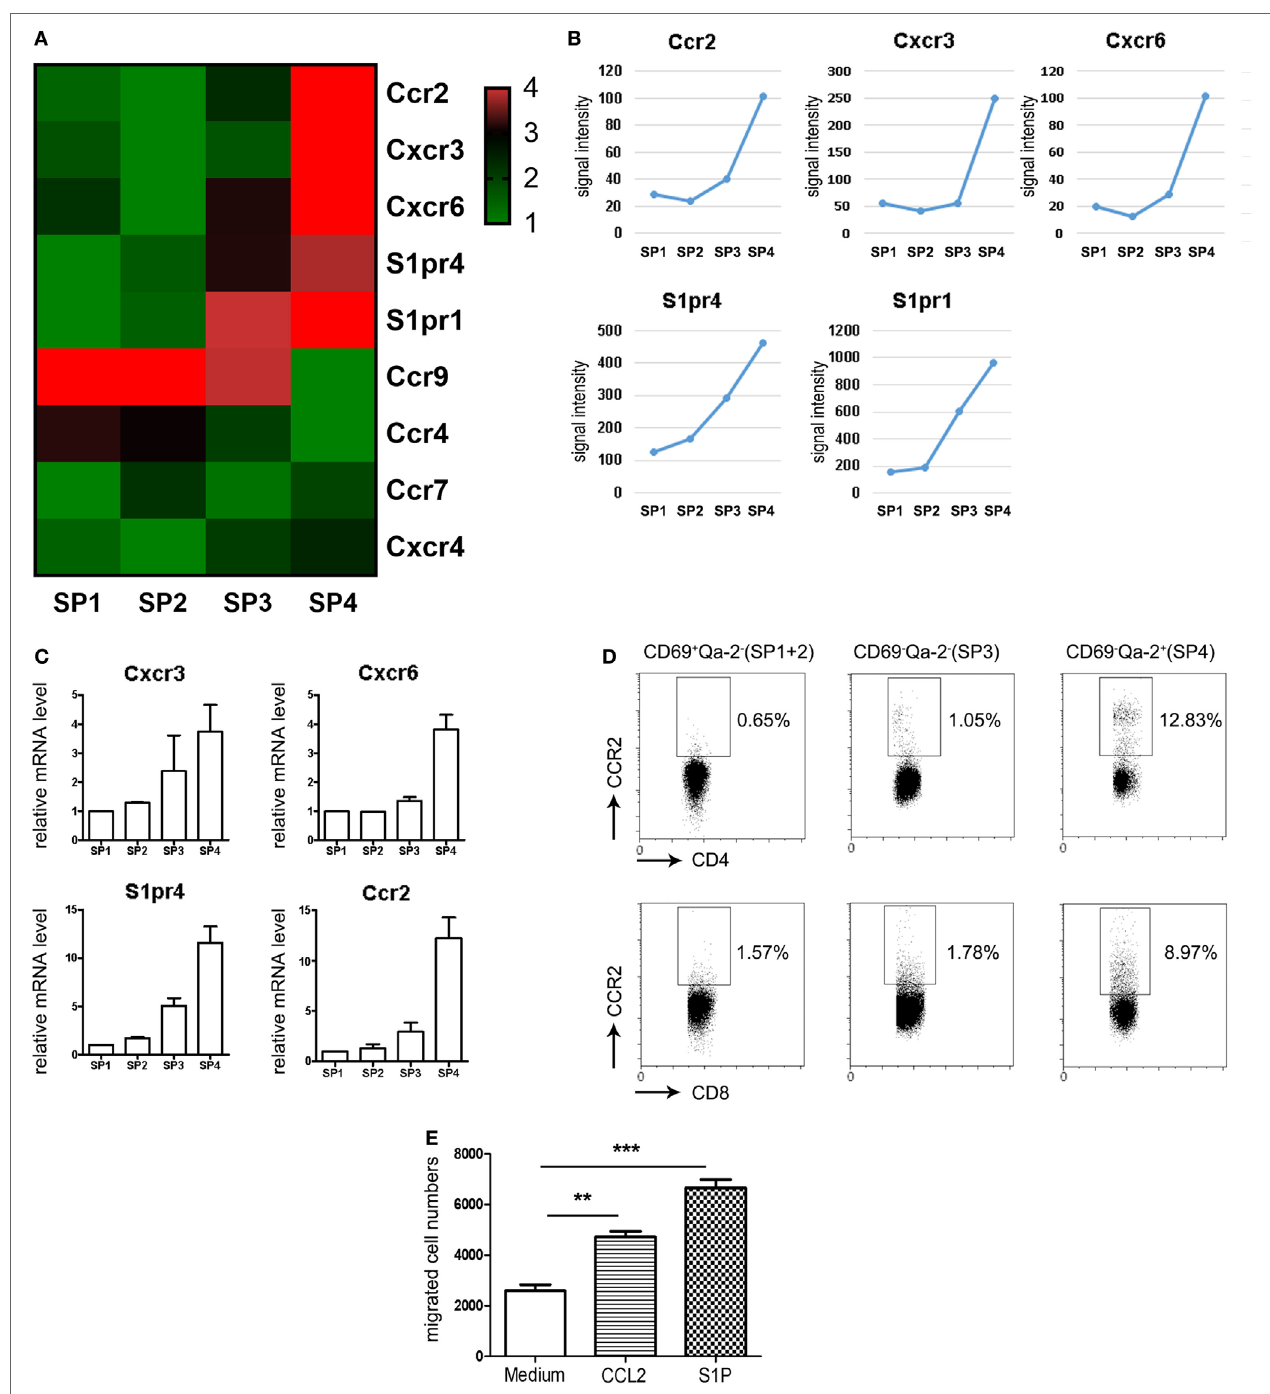
FigUre 1 | Restricted expression of CCR2 in CD69 − Qa-2 + mature CD4 single-positive (SP) thymocytes. (a,B) Genes encoding chemoattractant receptors were sorted out from the genes differentially expressed among the four subsets (SP1–SP4) of CD4 SP thymocytes. The expression patterns of these genes are depicted in heatmap (a) or line charts (B) . (c) Expression levels of Cxcr3 , Cxcr6 , S1pr4 , and Ccr2 were assessed in various subsets of CD4 SP thymocytes using qPCR. The experiments were repeated three times with triplicates for each sample and the data are presented as mean ± SEM. (D) CCR2 expression in CD69 + Qa-2 − (SP1 + SP2), CD69 − Qa-2 − (SP3), and CD69 − Qa-2 + (SP4) subsets of CD4 SP thymocytes as determined by flow cytometry. Representative dot plots are shown out of three independent experiments. (e) Purified CD69 − Qa-2 + SP4 thymocytes were tested for chemotaxis to CCL2 and S1P using transwell migration assay. Data from four independent experiments with duplicates are presented as mean ± SEM. Statistical differences between groups were determined by the Student’s t test. ** p < 0.01, *** p <